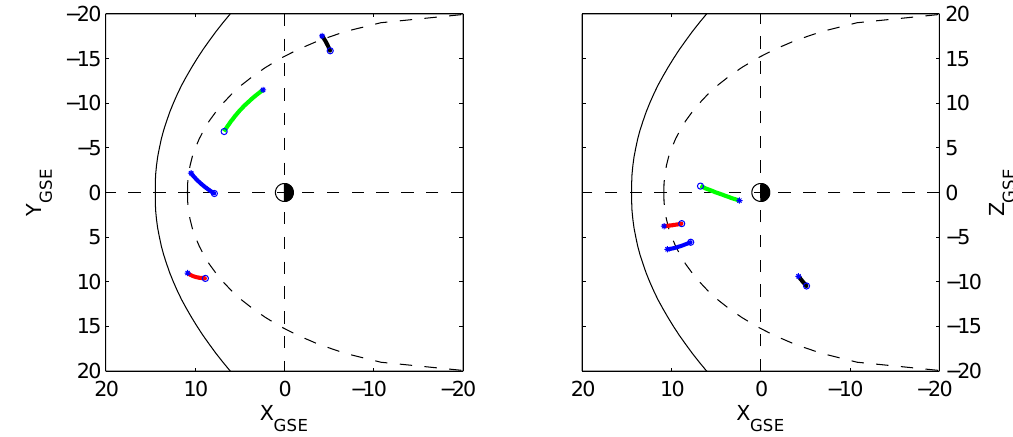
Fig. 4. Schematic of the location of the near-Earth spacecraft in the XY- and XZ-plane over the period of 16:00 (*) till 20:00 (O) UT, which shows how the spacecraft are moving in the magnetosheath (C1 black, Geotail green, TC1 blue, ThA red). The solid curved line is the bow shock and the dashed curved line is the magnetopause as in Fig.